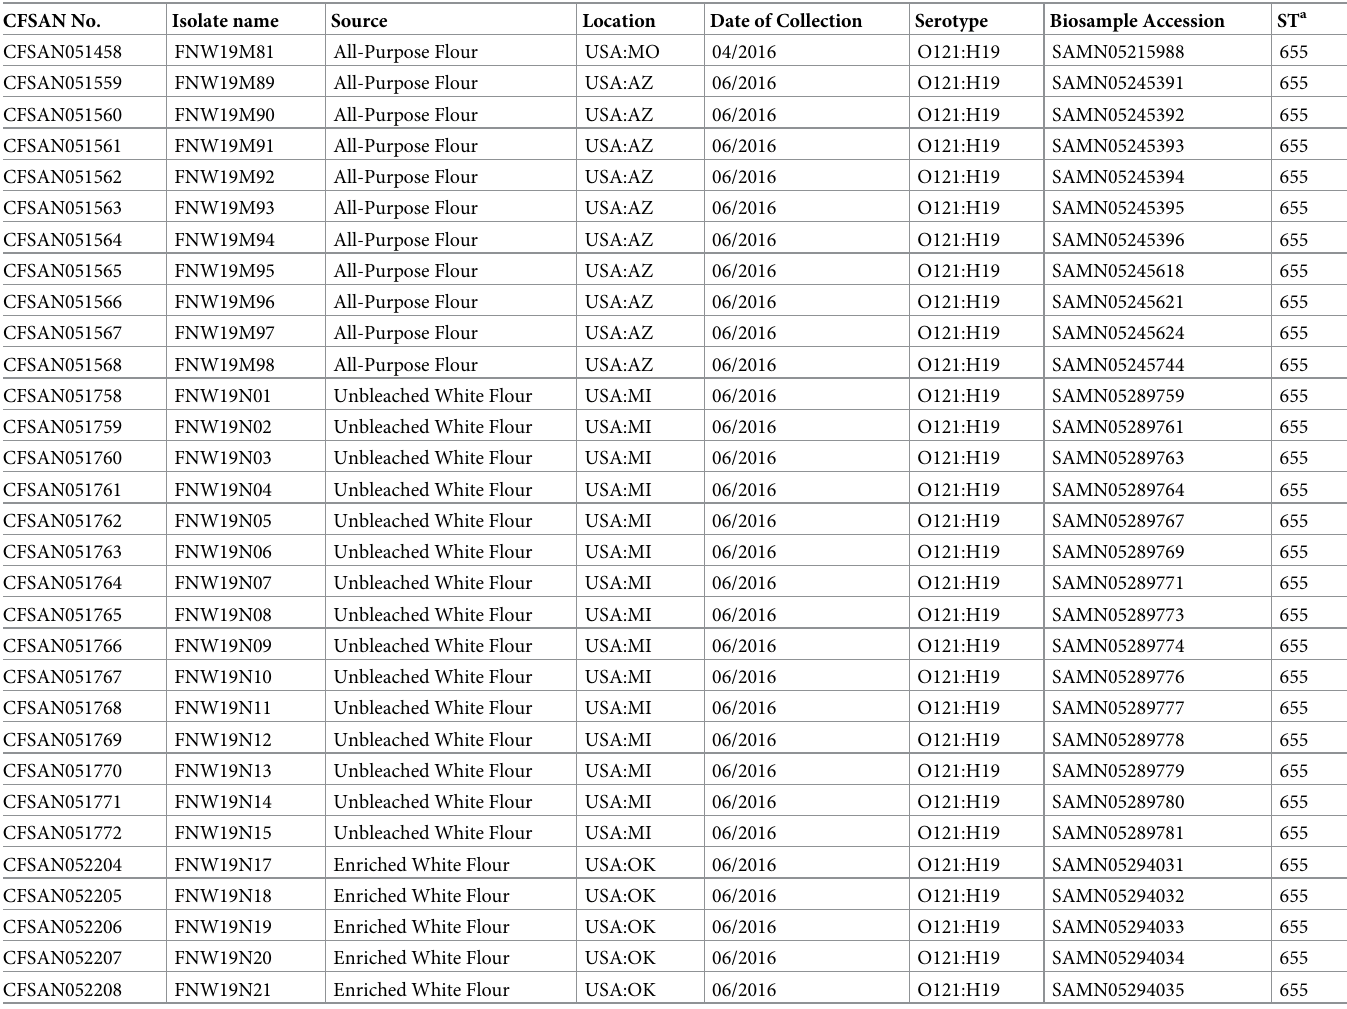
Table 1. Metadata for the 31 STEC strains used in this study. CFSAN